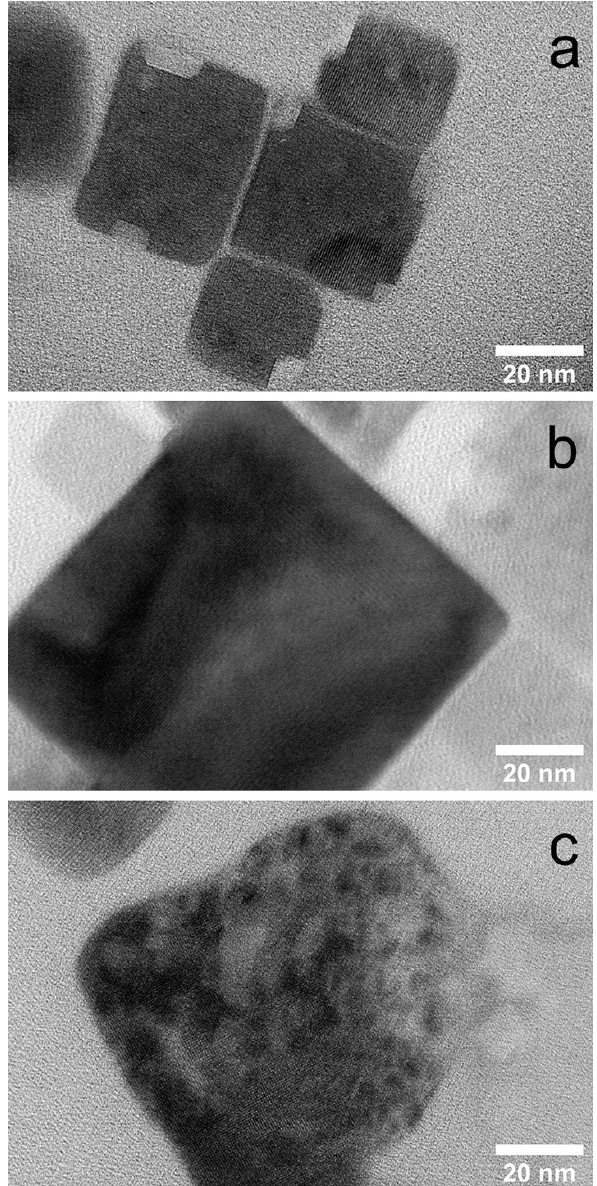
Figure 4. HRTEM images of the DCB-based nanohexagon solutions irradiated with 92 ( a ), 129 ( b ) and 165 ( c ) mJ/cm 2 fluence and 21.6 × 10 6 pulses.